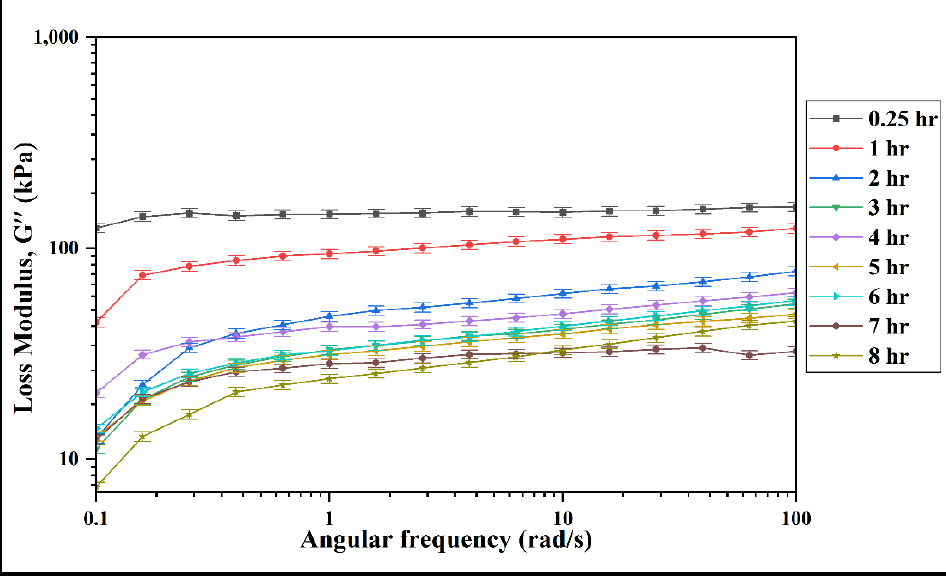
Figure 12. Loss modulus vs. angular frequency graphs at 9 different levels of waiting time.